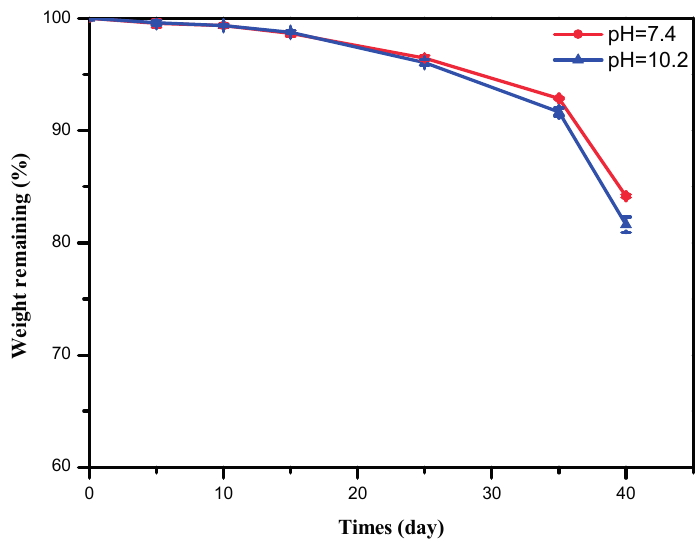
Figure 5. Remaining weight of PLH7.0 with degradation time in basic pH 10.2 and PBS pH 7.4.